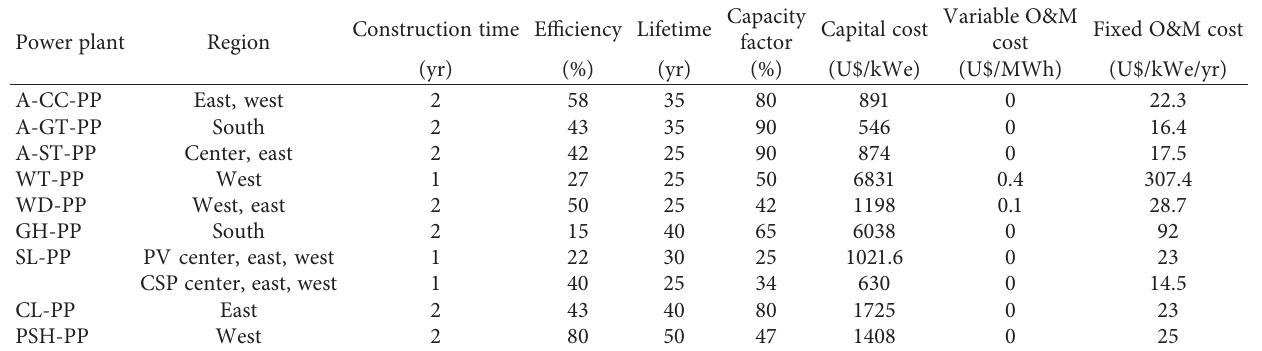
Table 3: The characteristic parameters of candidate nonnuclear PPs assumed in this study [67–73] (1) .